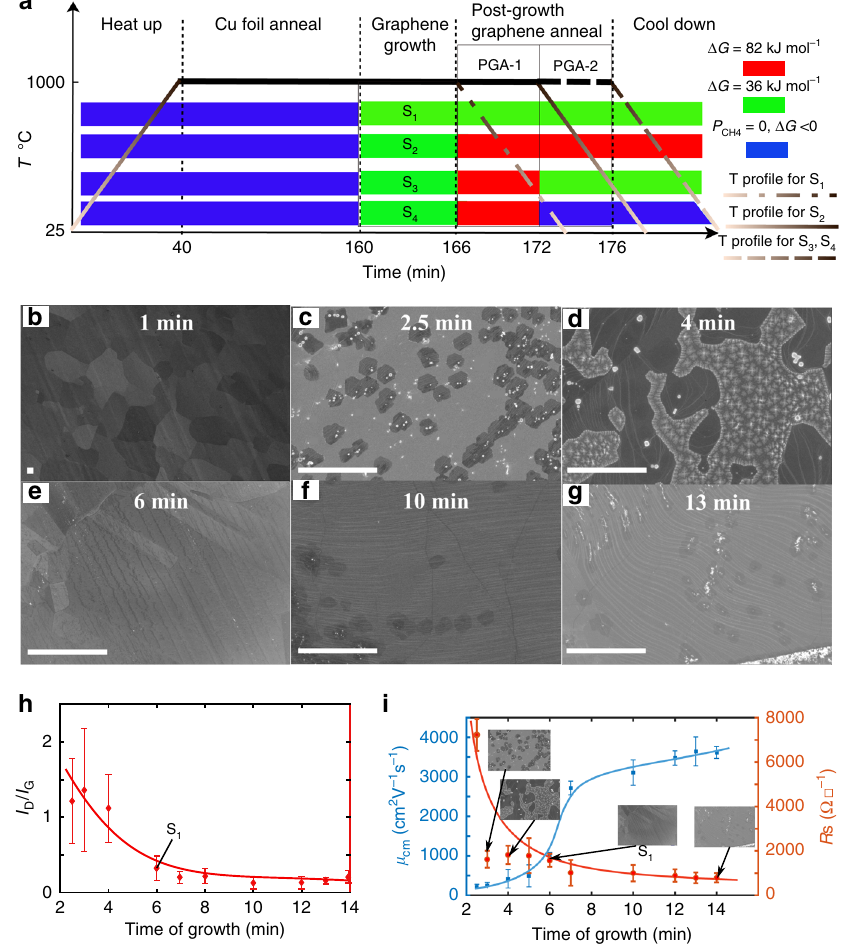
Fig. 1 Growth and characteristics of the reference graphene group G 1 . a Graphene growth conducted in this work and the steps involved are described schematically. The growth atmosphere is color coded and the legend shows the supersaturation conditions. S 1 – S 4 refer to four different samples as listed in Table 1. b – g SEM images of various stages of graphene growth on Cu under conditions used for the standard group G 1 . Growth time (from 160th minute in Fig. 1a) is indicated in the photographs. b Incubation period, t < 2 min, in which no nuclei are formed. c Nucleation stage, t = 2.5 min, in which domains of size ~ 2 µ m are observed. d Growth stage, t = 4 min, in which individual domains grow by adatom addition until they merge with other similarly growing domains. e Visually coalesced graphene (VCG) observed after 6 min of growth. This sample is referred to as S 1 and serves as a reference. f Surface image after 10 min of growth. g Surface image after 14 min of growth. The bright spots are Cu particles that are deposited from the vapor phase during cool down on exposed Cu areas. h The time evolution of fi lm defect density as measured by Raman spectroscopy. i Charge mobility ( μ cm ) and sheet resistance ( R s ) evolution with growth time. While µ cm shows a four-fold change after visual coalescence at 6 min, Raman defect density remains almost unchanged. A Gompertzian-Sigmoidal fi t (blue continuous line in i ) to the charge mobility is also shown. Scale bars in b – g : 10 µ